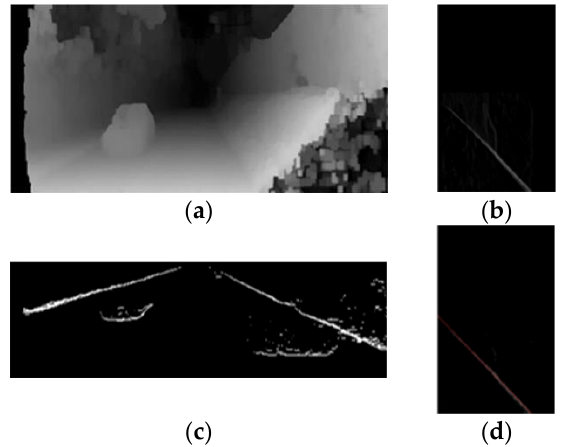
Figure 3. Projection result of the disparity image in the horizontal and vertical directions: ( a ) disparity image; ( b ) V-disparity image; ( c ) U-disparity; and ( d ) line of road surface.